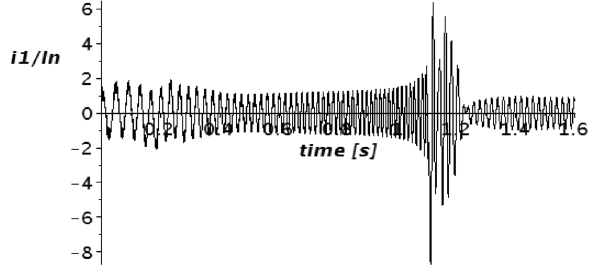
Fig. 23 Phase current of the induction motor during the frequency starting with the linear frequency increase